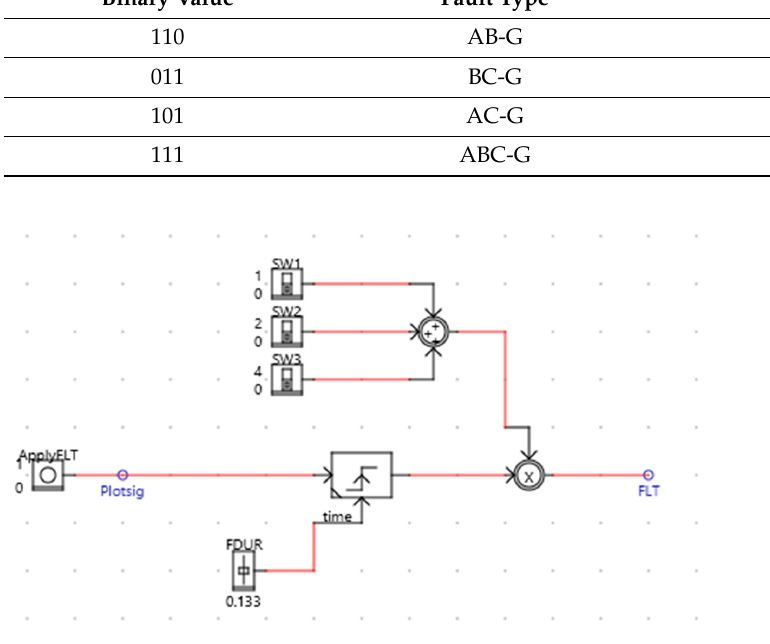
Figure 19. Fault logic.